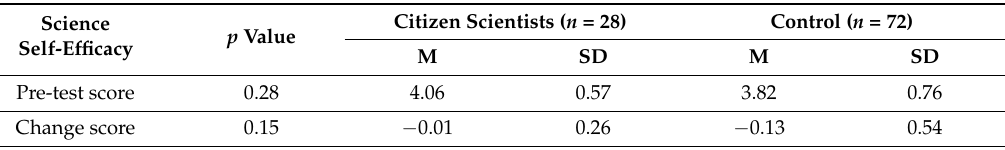
Table 5. Joint display of science self-efficacy mean (M) pre-test and change scores, standard deviations (SD), Mann–Whitney U p -scores and qualitative findings.